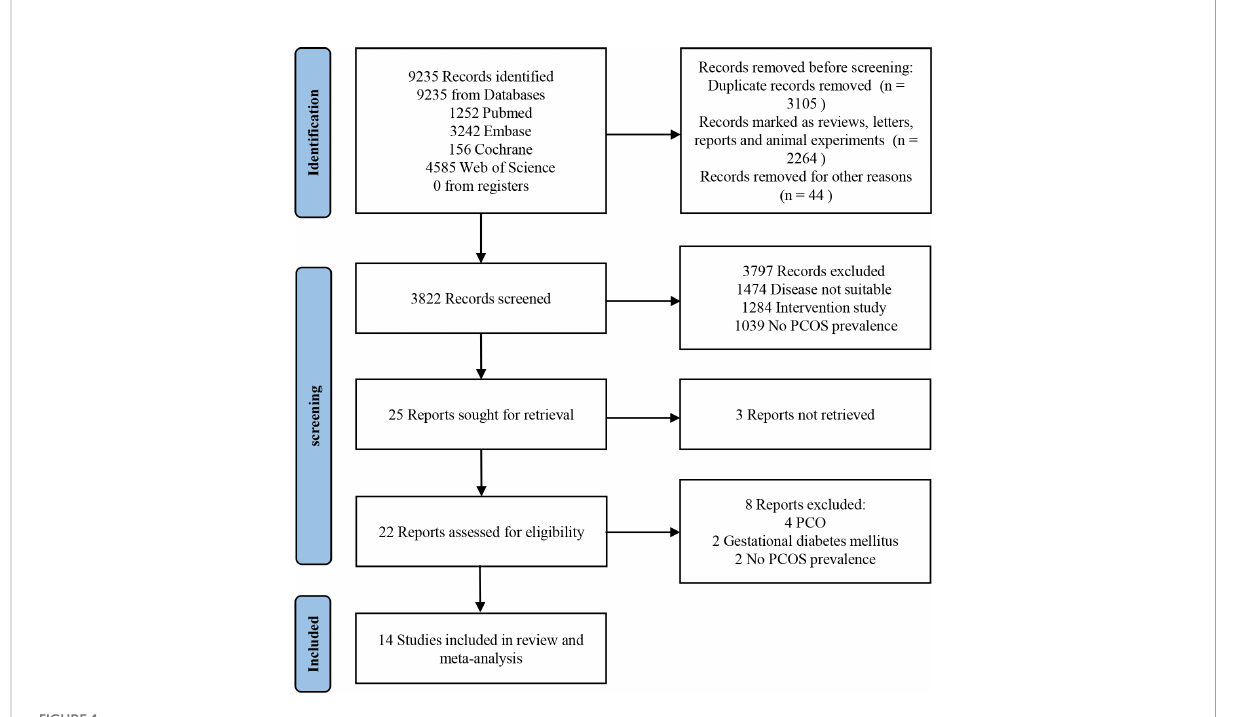
FIGURE 1 Study Flow